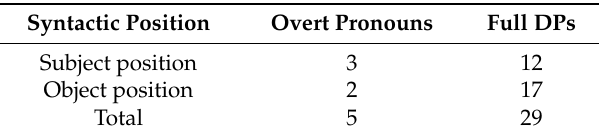
Table 6. Raw frequencies of overspecified overt pronouns and full DPs in subject position and object position. Syntactic